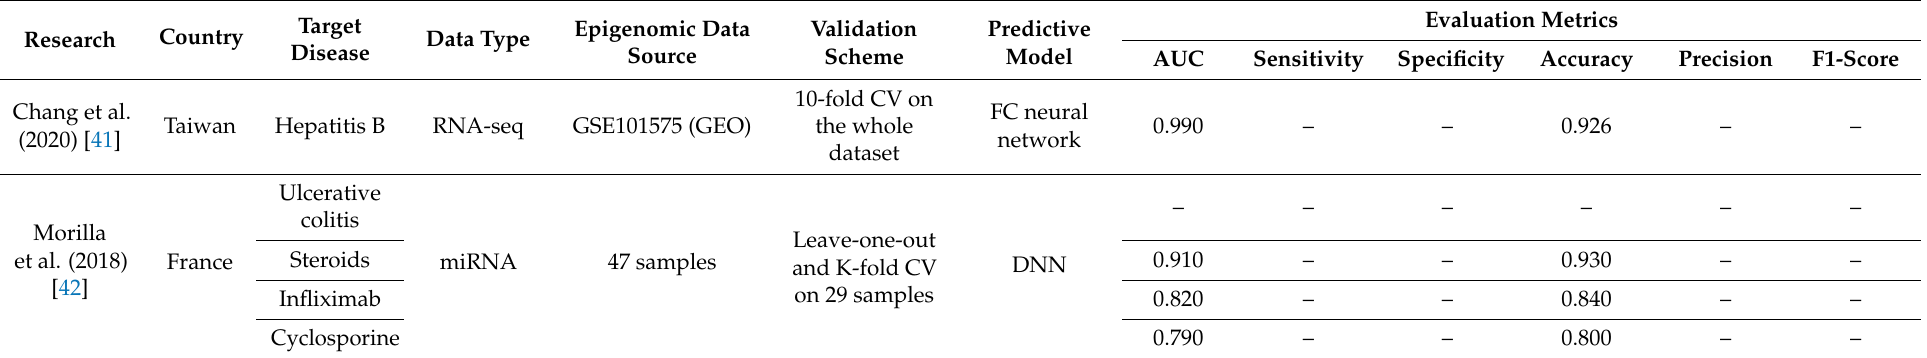
Table 4. Comparison of DL models for treatment response prediction using epigenomic